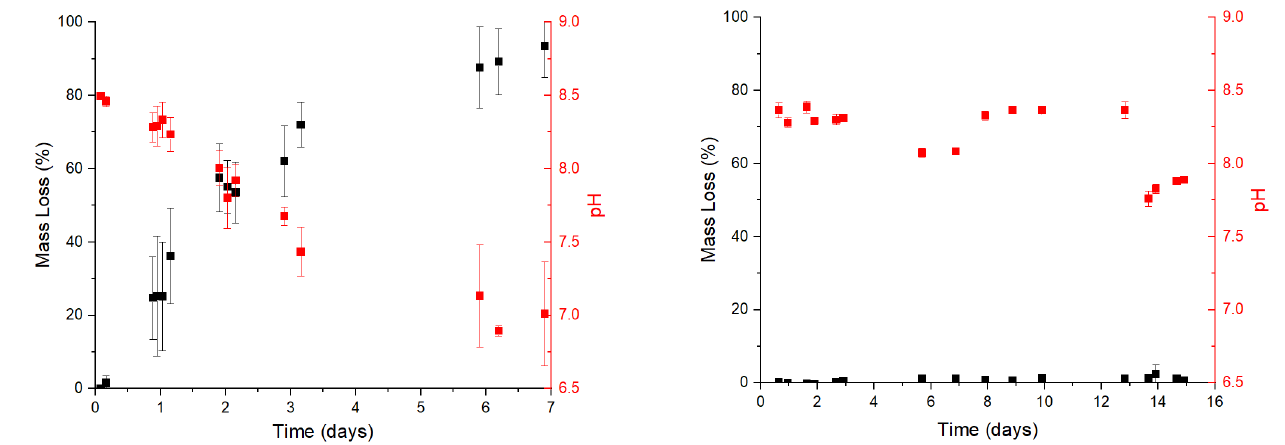
Figure 3. Biodegradation test of PLA ( left ) and PLA crystallized ( right ) in terms of mass loss (%) and pH. Full disintegration of the films is obtained after 7 days in the buffer solution for the PLA samples. The stability of the films became quite irregular after one day when the sample obtained a significant degradation (over 20% of the sample mass). After 7 days it was impossible to measure the films samples as they were disintegrated. Small particles could be seen in the solution, but the weight was negligible. Thus, the oligomers produced from PLA degradation have to be smaller enough to be solved in the enzyme solution.